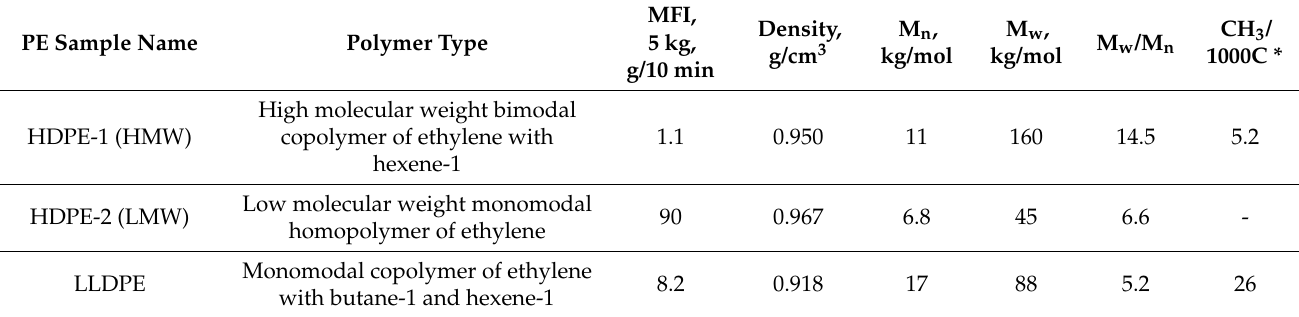
Table 1. Characteristics of high-density polyethylene (HDPE) and low-density polyethylene (LLDPE).